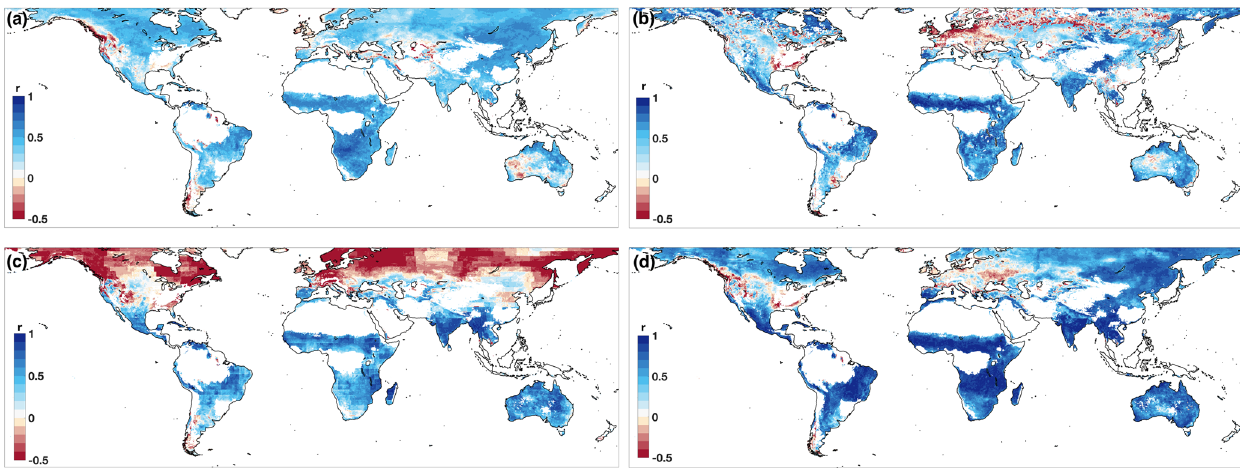
Figure 7. Vegetation response to different sources of soil water availability as indicated by the correlation between monthly NDVI and (a) antecedent precipitation index (API), (b) SMOS surface soil moisture retrievals, (c) GRACE total water storage change retrievals, and (d) vegetation-accessible water storage derived after the joint